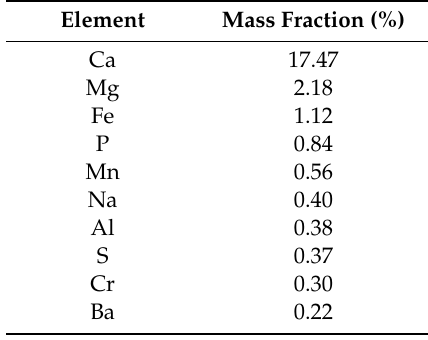
Table 3. Mineral composition of the ash of the selected gasification char, determined by means of ICP-OES analysis. Only the elements with mass fraction greater than 0.20% are reported.